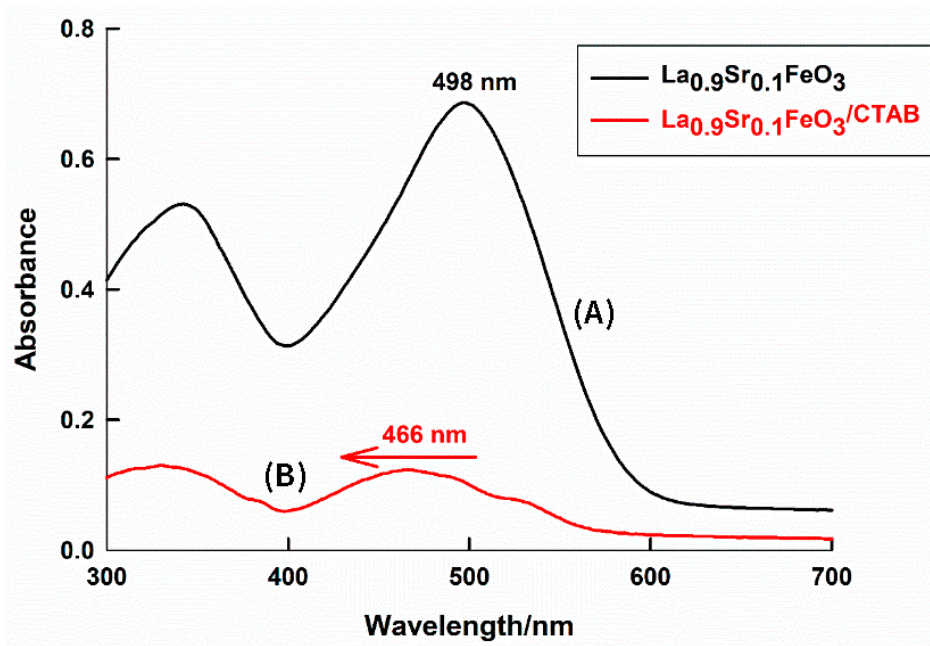
Figure 3. Visible absorption spectra of remaining CR dye in solutions by using ( A ) pure, and ( B ) CTAB-capped La 0.9 Sr 0.1 FeO 3 sorbents at pH = 6, the dye concentration = 10 ppm, contact time = 24 h, at 25 ◦